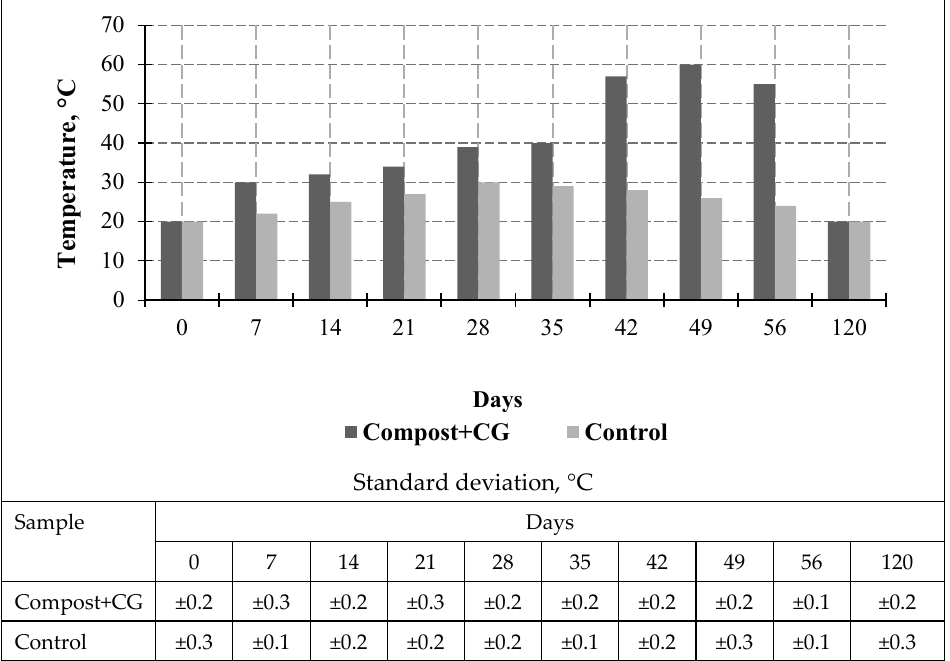
Figure 5. Temperature changes during composting.